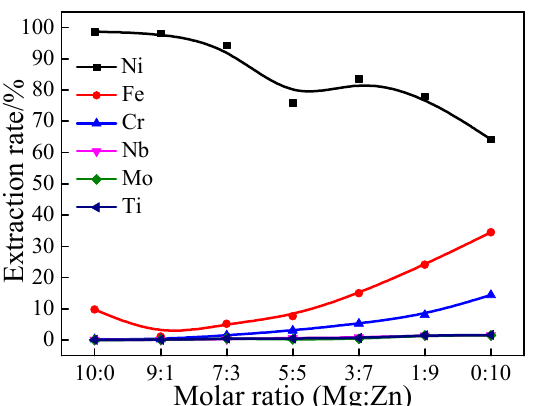
Figure 8. Effect of the molar ratio of Mg to Zn on the extraction of metals from the superalloy (Note: the curves for Nb, Mo and Ti are overlapping).